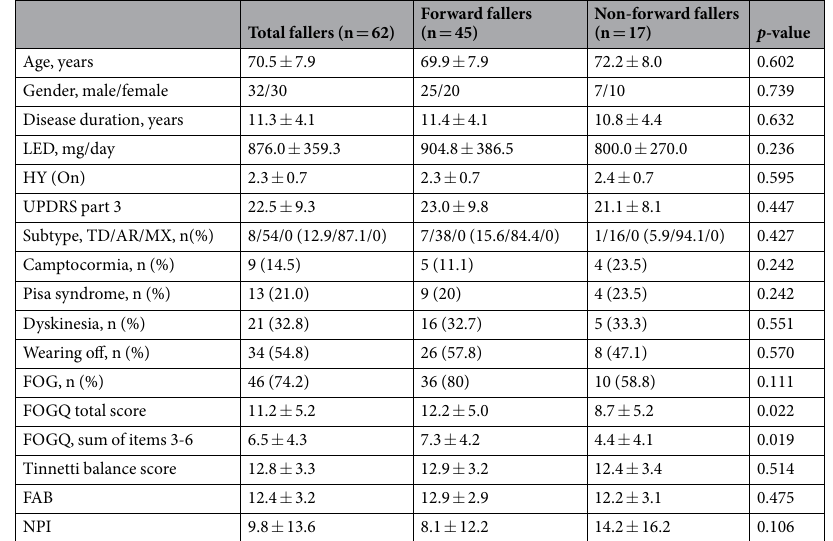
Table 1. Demographic and clinical data of recurrent fallers with Parkinson’s disease. PD, Parkinson’s disease; LED, daily levodopa equivalent dose; HY, Hoehn and Yahr stage; UPDRS, unified Parkinson’s disease rating scale; FOG, freezing of gait; FOGQ, freezing of gait questionnaire; FAB, frontal assessment battery; NPI, neuropsychiatric inventory.